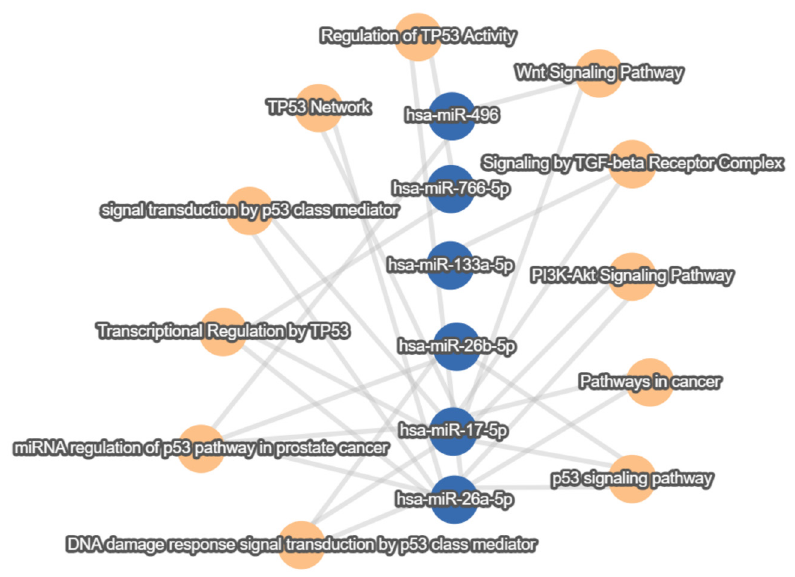
Figure 4. Strong and weak experimentally validated shared target pathways downstream of the CRC exosomal lncRNA/circRNA–miRNA–target axis. Orange nodes indicate pathways, and blue nodes indicate miRNAs. Minimum miRNA threshold = 3.